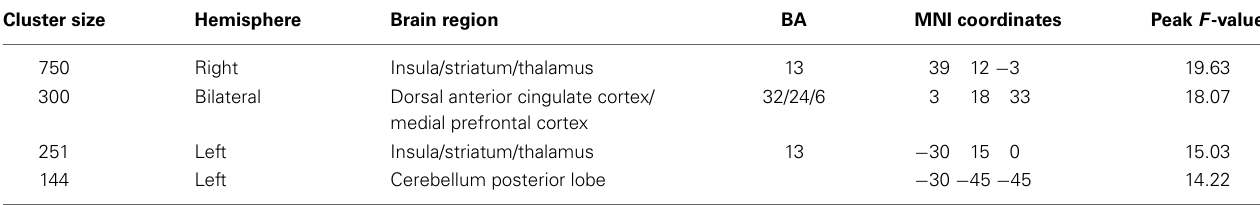
Table 5 | Sex by the general risk propensity score interaction effects on the RSFC in the right SII seed